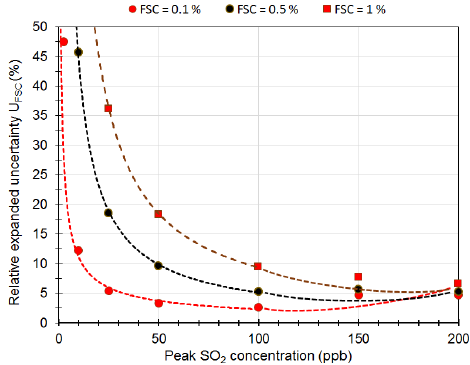
Figure 13. The expanded uncertainty of FSC, U FSC (%), as a func- tion of the SO 2 peak height concentration for three FSC limits: